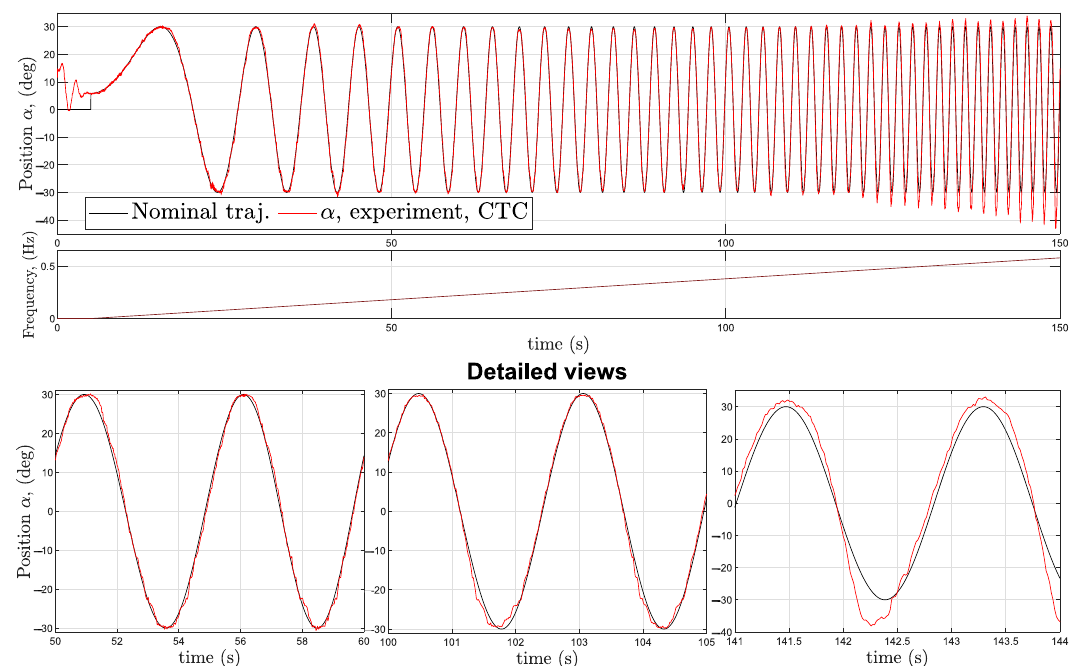
Figure 11. Experimental trajectory tracking for a sinusoidal trajectory with increasing frequency.